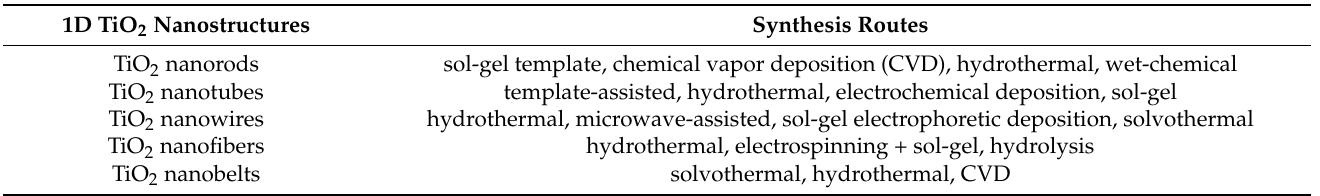
Figure 3. Categorization of hierarchical TiO 2 nanostructure form [48]. Reproduced with permission from Elsevier, 2022. Table 2. Several synthesis strategies for obtaining 1D TiO 2 photocatalysts [48,50].